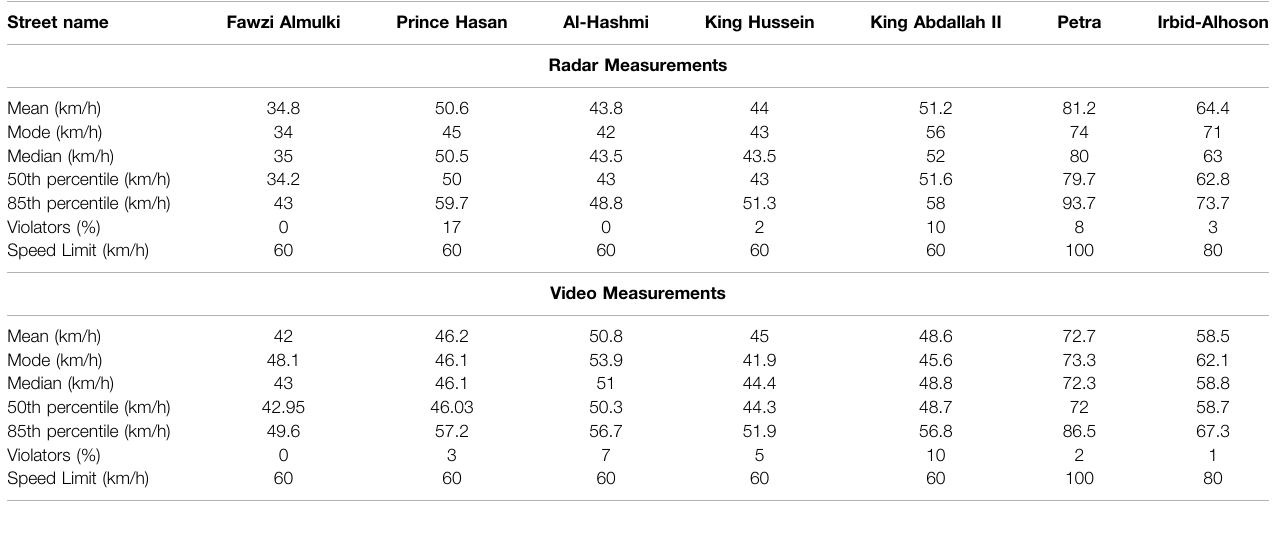
TABLE 4 | Descriptive statistics for radar and video measurements.